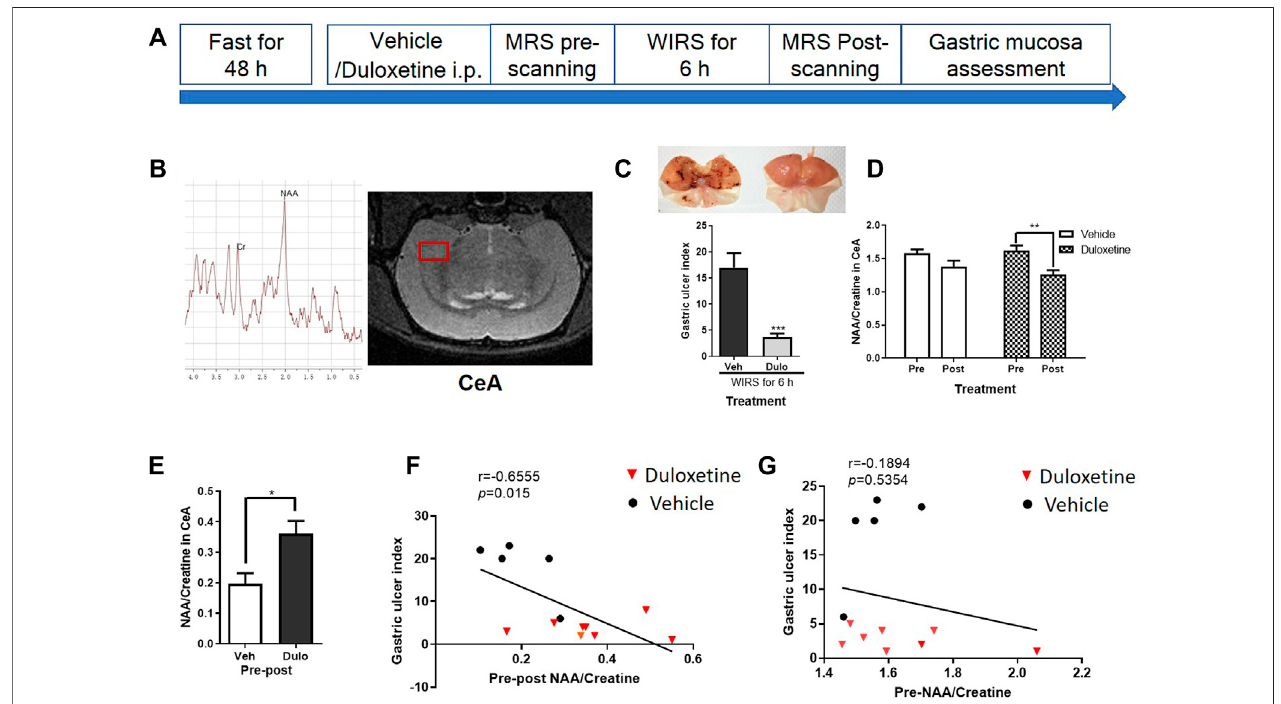
FIGURE 1 | H-MRS showed difference of change of NAA/Cre ratio in the right CeA during WIRS between duloxetine and vehicle groups and correlation between gastric ulcer index and NAA/creatine in the right CeA when prophylactically protecting the gastric mucosa. (A) Illustration of the general timeline of the study. (B) Typical spectraimagesand schematicdiagramofright CeAwithvoxellocalizationacquired fortherat.RightCeAwasoutlined bythered box.Each spectrum wasevaluatedfor thepeak areaofNAAat 2.02 ppm,and creatine at3.03 ppm. (C) Representativecameraimagesofgastric mucosaand gastric ulcerindex. ( n =5invehicle group, n =8induloxetinegroup).*** p < 0.001,comparedwithvehiclegroup. (D) NAA/creatineratiointherightCeAinpretreatedvehicleandduloxetinegroupsbeforeandafter WIRS. * p < 0.05, compared withbeforeWIRS ofvehicle-treated group;## p < 0.01,comparedwithbeforeWIRSofduloxetine-treatedgroup. ( n =5invehiclegroup, n = 8induloxetinegroup). (E) ChangeofNAA/creatineratiointherightCeAbetweenpre-andpost-WIRSinthevehiclegroupwaslessthantheduloxetinegroup.* p < 0.05, compared with change of NAA/creatine between post- and pre-WIRS in CeA of vehicle. (F) Relationship of change of NAA/creatine ratio in the right CeA with severity of gastric mucosadamage induced byWIRS forboth vehicleand duloxetine groups. Signi fi cantlinearcorrelationwasobservedbetweengastric ulcer index and changeof NAA/creatine ratio in the right CeA for all the rats. (G) Relationship of NAA/creatine ratio in the right CeA 30 min after drug administration with severity of gastric ulcer damage induced by WIRS for both vehicle- and duloxetine-treated rats. No signi fi cant correlation was found between gastric ulcer index and NAA/creatine ratio in the rightCeAforalltherats.Alldataaremeans±SEM.Note:NAA,N-acetylaspartate;Veh:vehicletreatment group;Dulo:duloxetinetreatment group;Pre:pre-WIRS;Post: